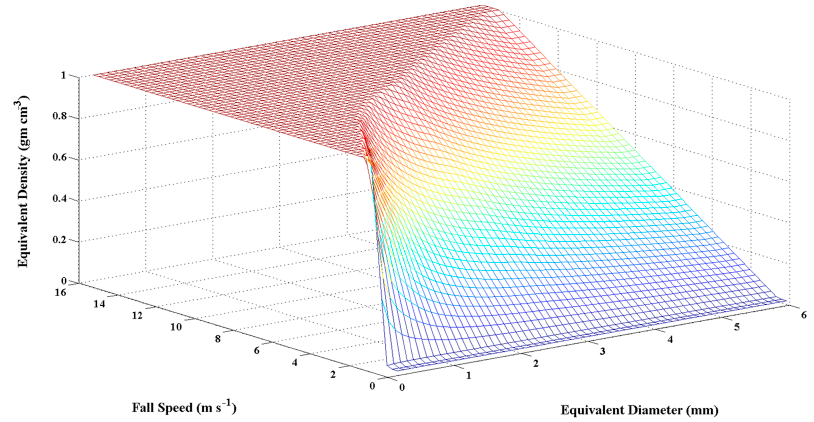
Figure 1. Three-dimensional visualization of the relation of ρ e parameterization. The vertical axis illustrates the ρ e values, while horizontal plane axes represent the fall speed and D e